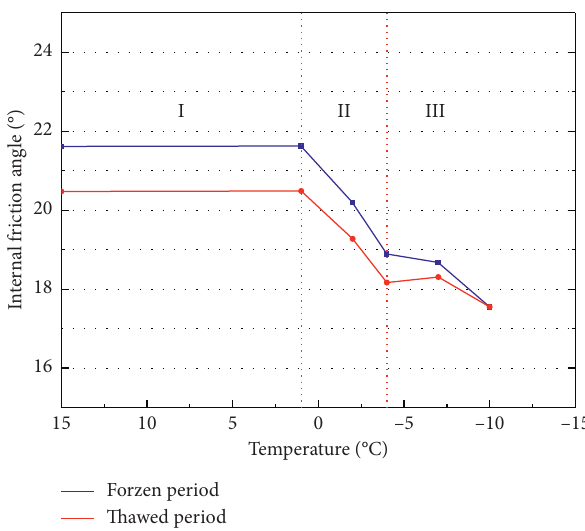
Figure 6: Variation of internal friction angle of soil with tem- perature during freezing and thawing process [44].